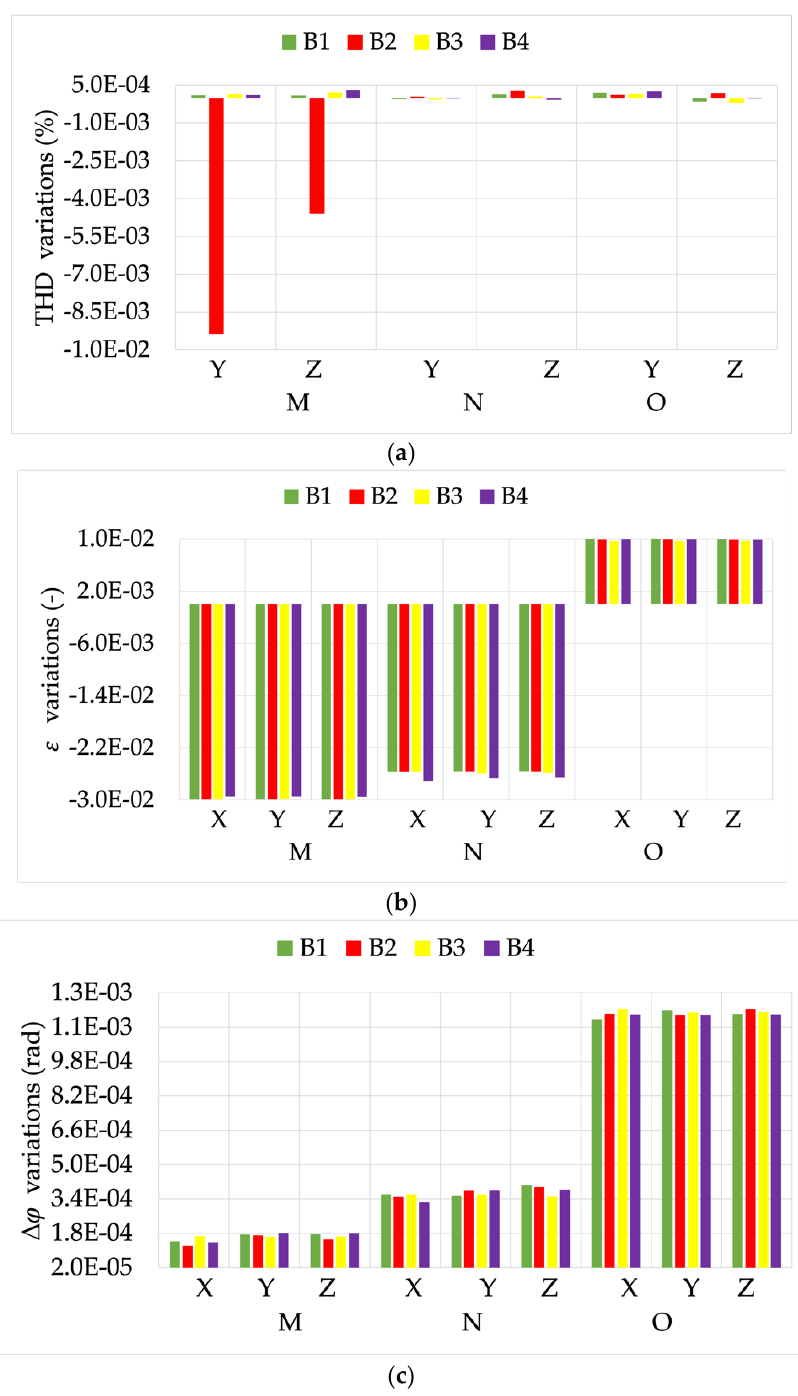
Figure 16. ( a ) THD, ( b ) 𝜀 , and ( c ) ∆𝜑 variations, from the tests vs. burden and position, for RC